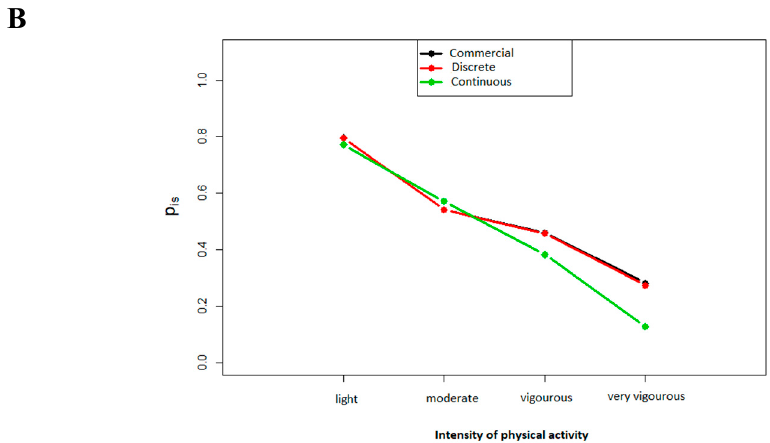
Figure 7. ( A ): Average and standard error of the mean of activity count classification results for the commercial activity count, the discrete and the continuous methods; ( B ): Relative effects of the three algorithms (commercial, discrete and continuous methods).